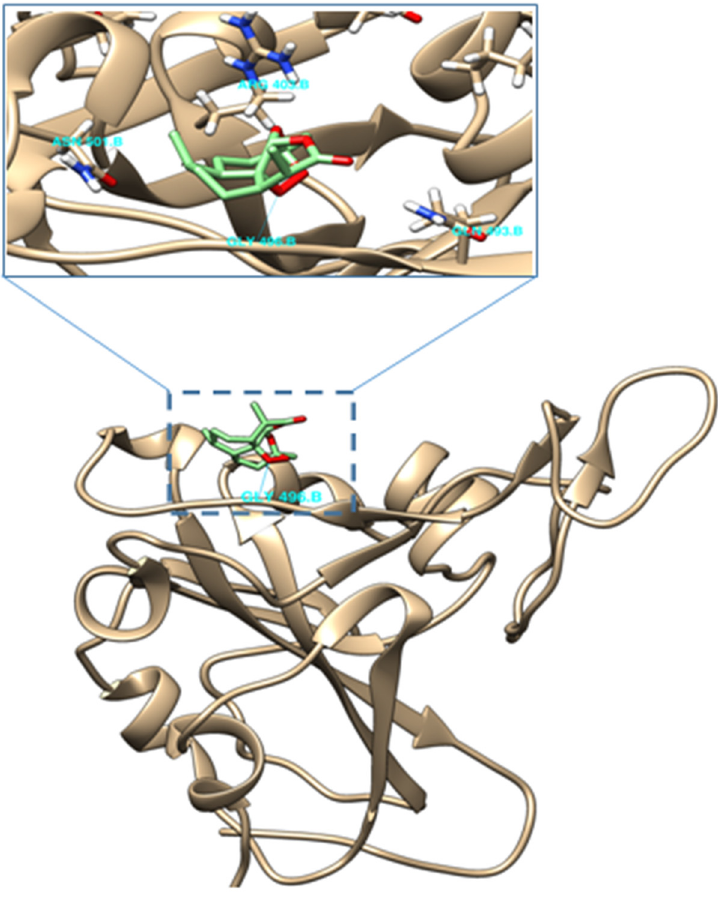
Figure 5. Interaction of ( − )-6-epi-artemisinin ( 2 ) with the RBM of the spike protein of SARS-CoV-2 (Lys-353 binding hotspot).